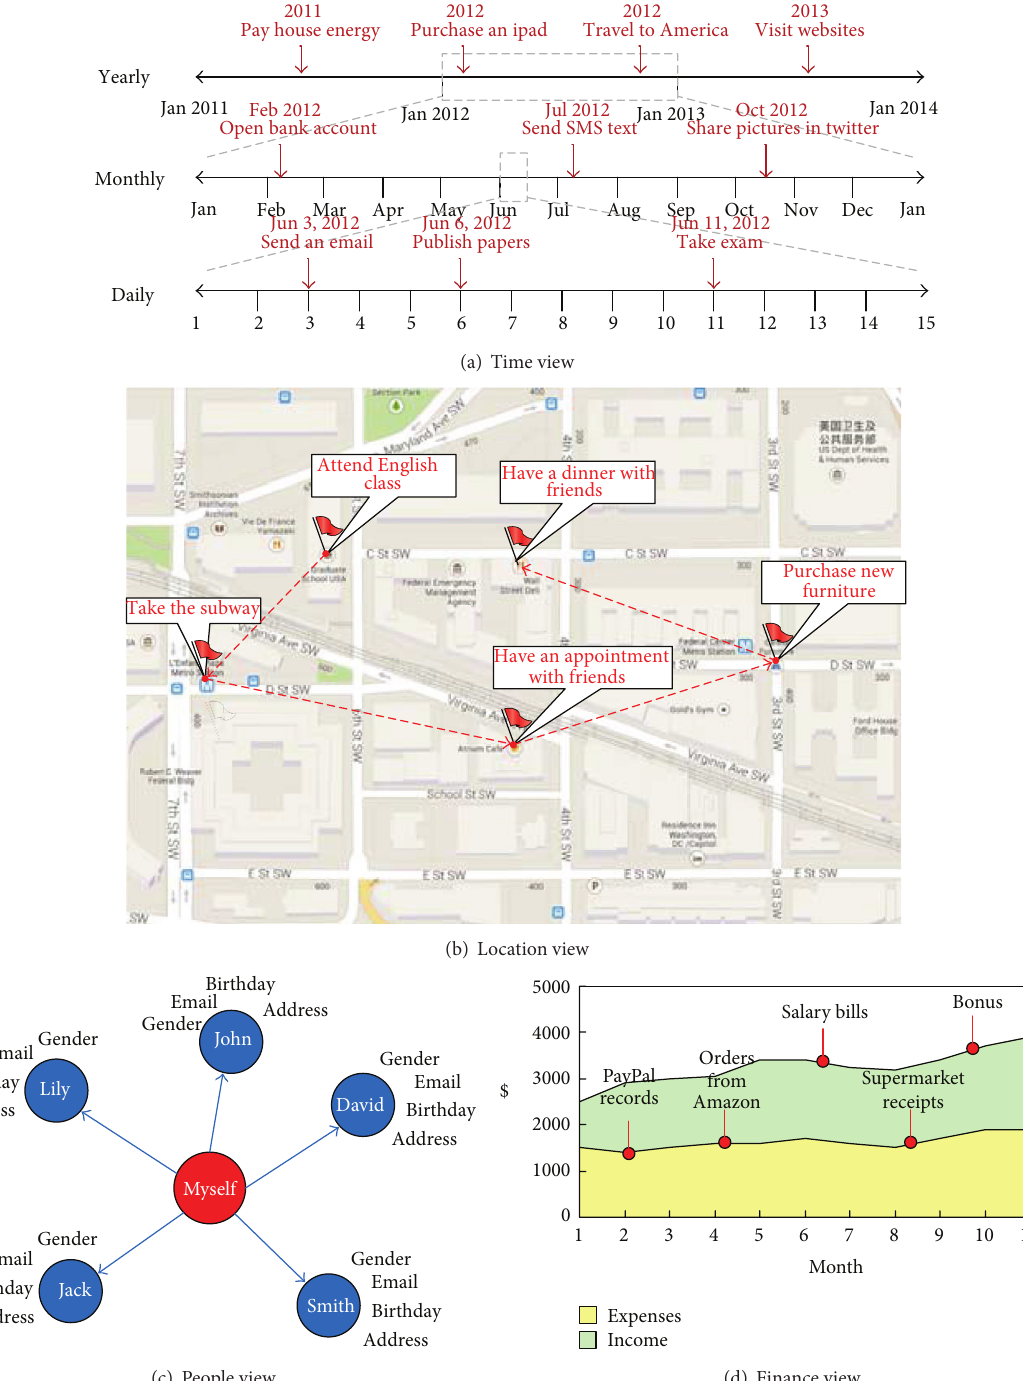
Figure 3: Personal data visualization for four different